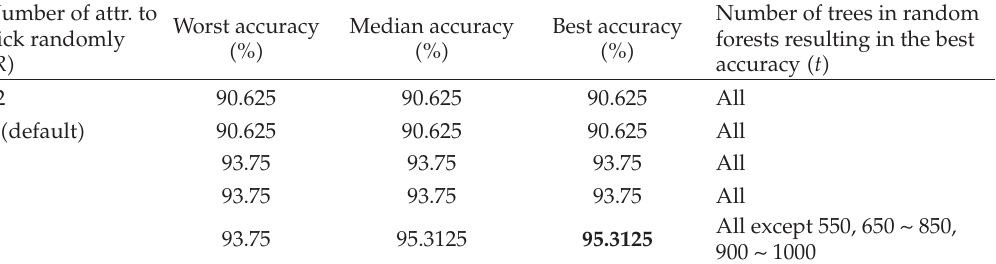
Table 13: The accuracy of random forests for the data set “DB world.”